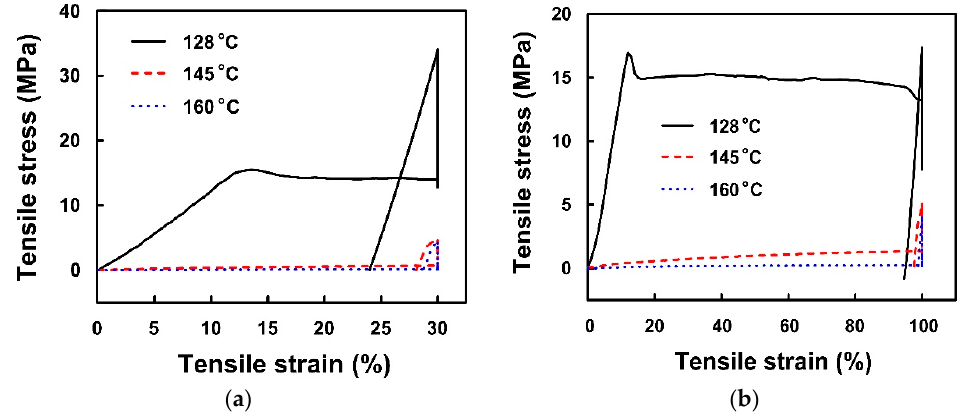
Figure 8. Typical stress versus strain curves in uni-axial tension at different temperatures to maximum programming strains of 30% ( a ) and 100% ( b ) and then unloading after cooling to room temperature.